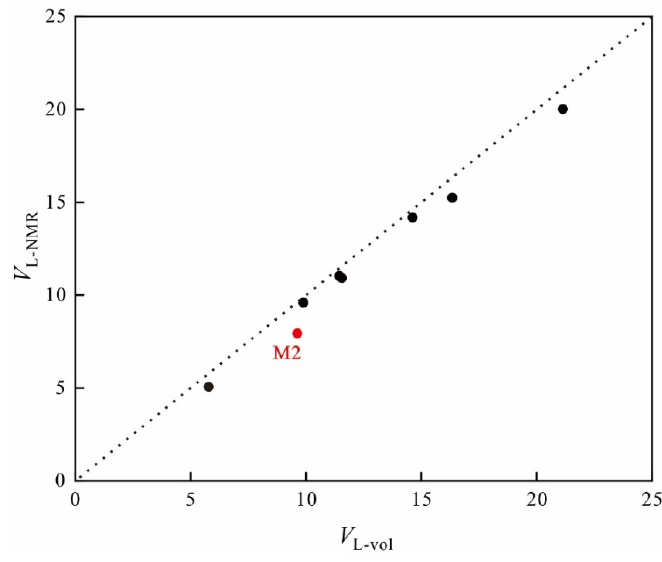
Figure 9. Scatter plots of Langmuir volume obtained from two contrasting methods.